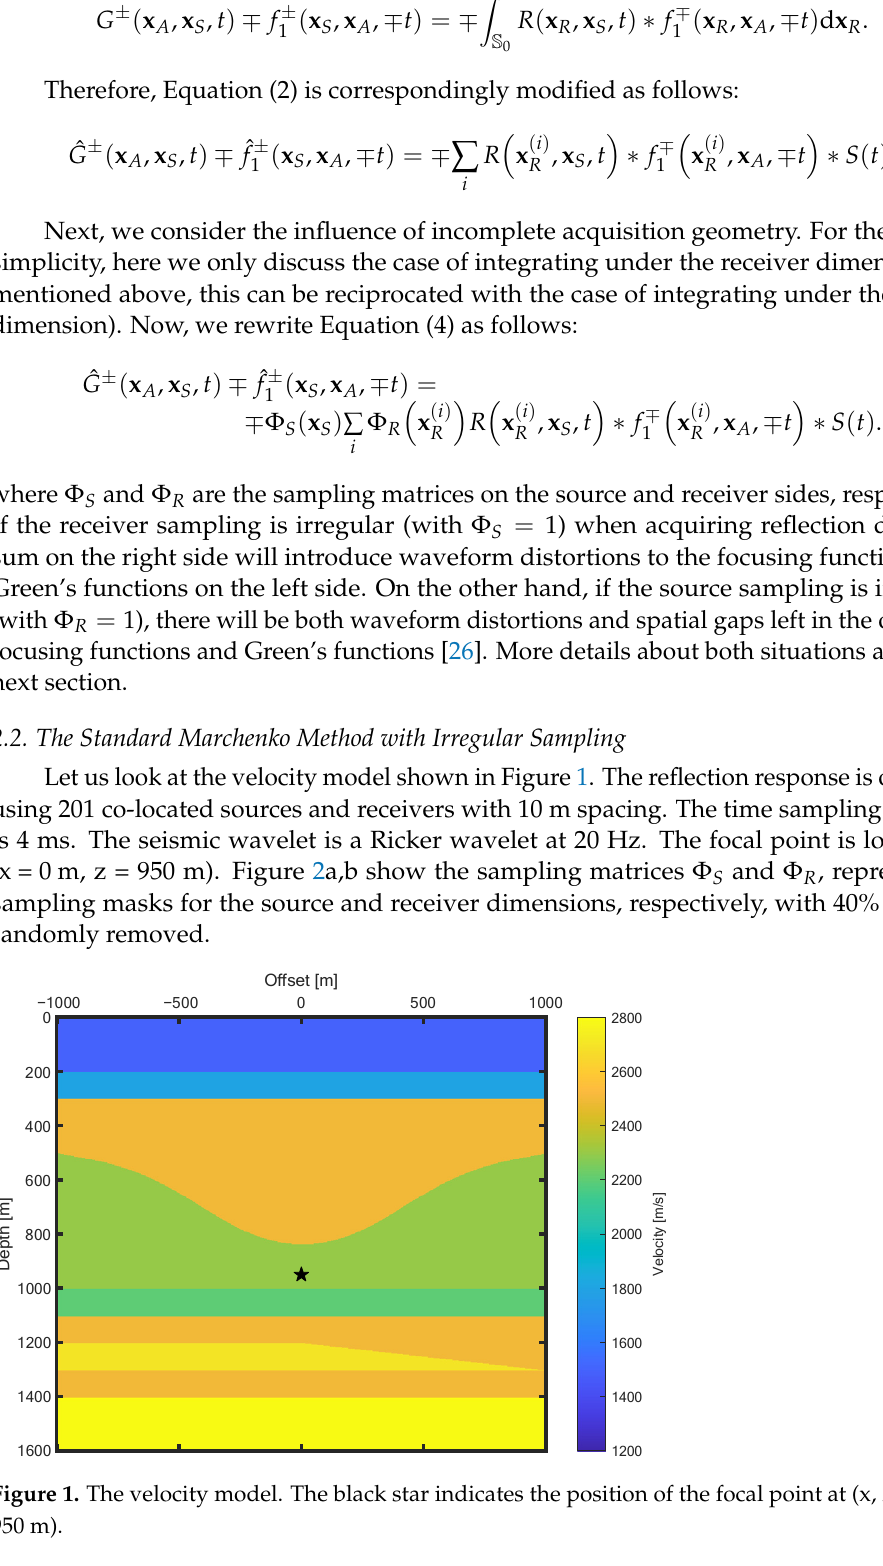
Figure 2. The sampling matrices. ( a ) is S Φ (under the source dimension), and ( b ) is R Φ (under the receiver dimension).